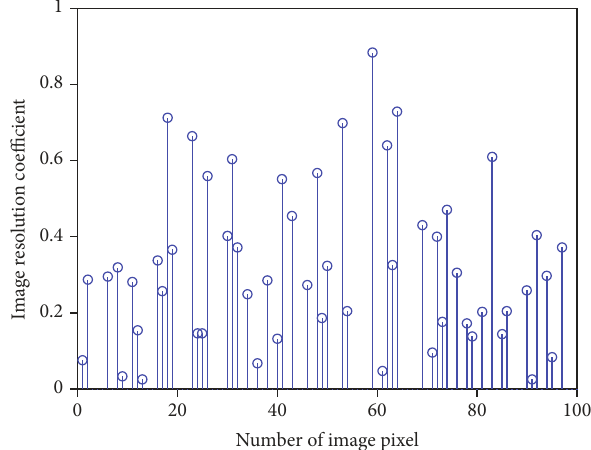
Figure 8: Image resolution coe ffi cient matchstick diagram of di ff erent